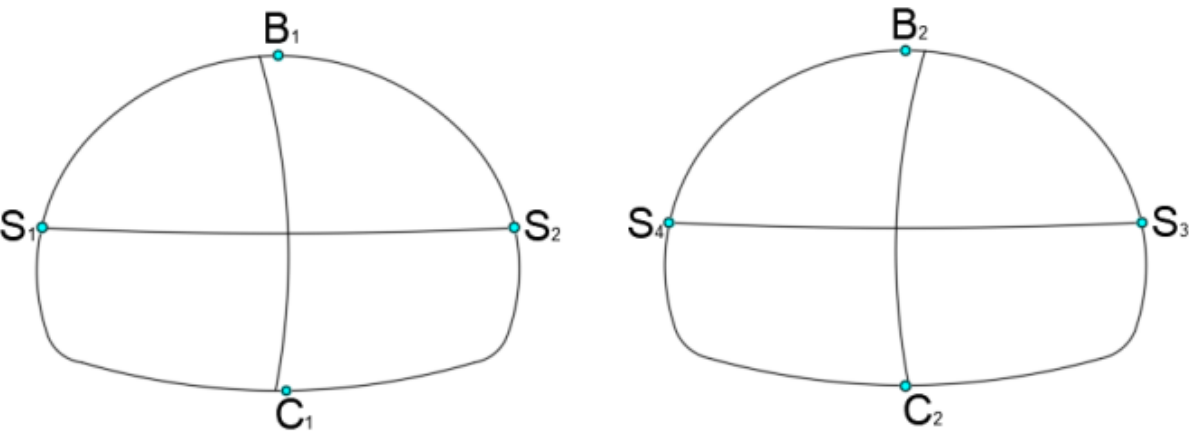
Figure 5. Layout drawing of the separated tunnel surveying points.